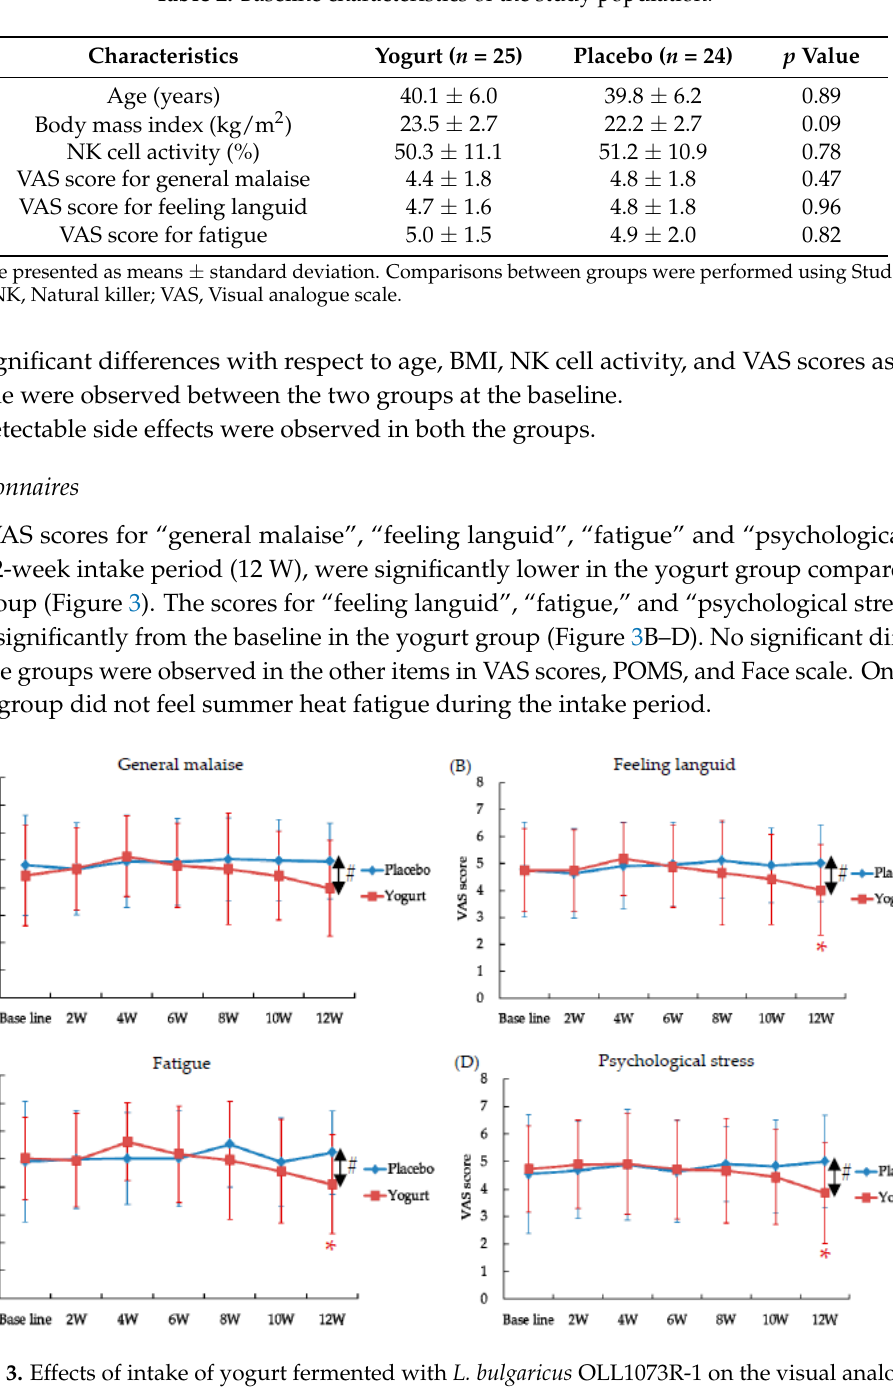
Figure 2. Study flow diagram. Table 2. Baseline characteristics of the study population. Table 2. Baseline characteristics of the study population.